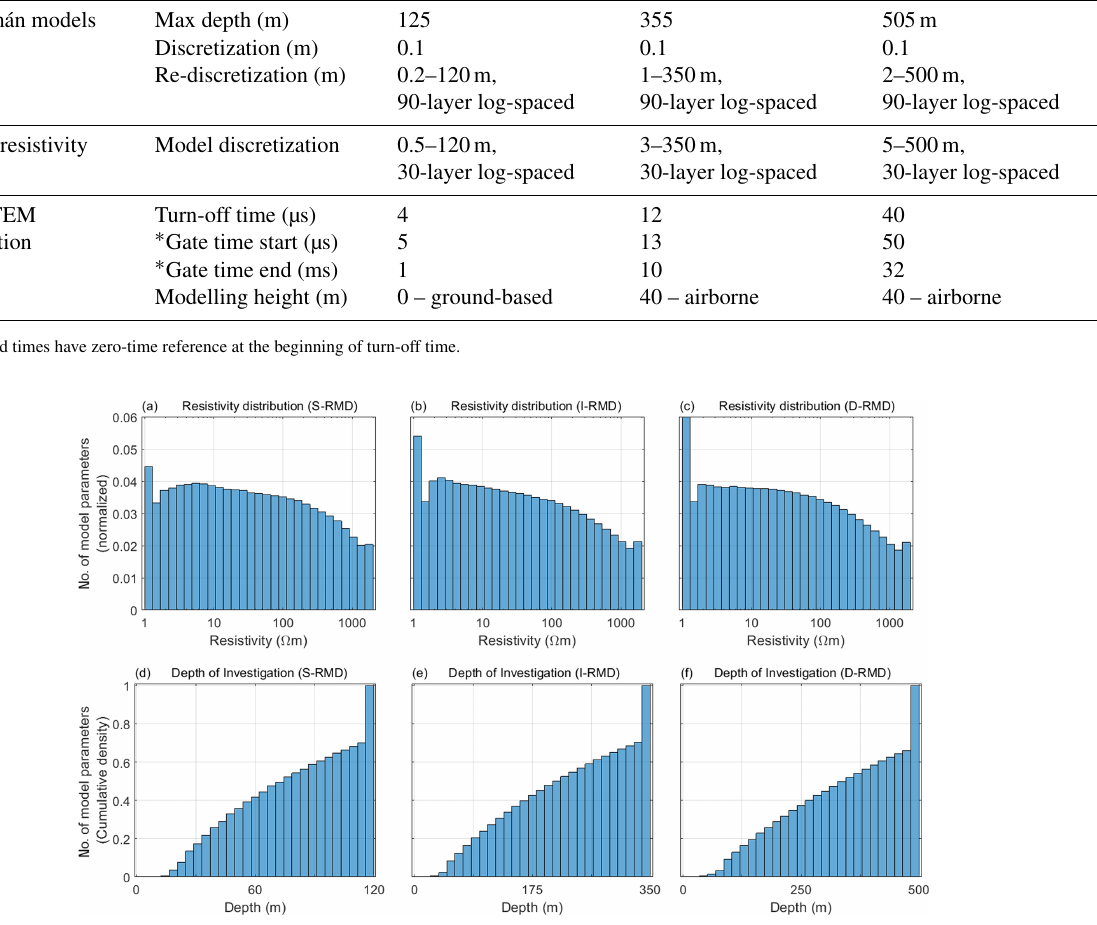
Figure 2. Statistical insights into the DL-RMD. (a–c) Resistivity distributions of the S-RMD, I-RMD, and D-RMD, respectively. (d–f) Distributions of depth of investigation of models in the S-RMD, I-RMD, and D-RMD, plotted as a cumulative